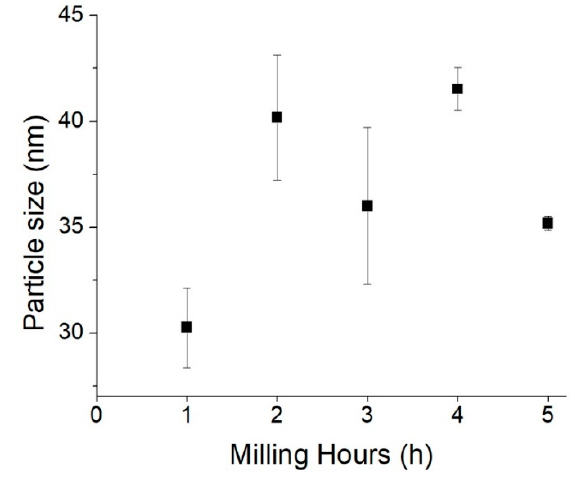
Figure 2. Average MoB 2 particle size vs. time of high-energy ball milling.